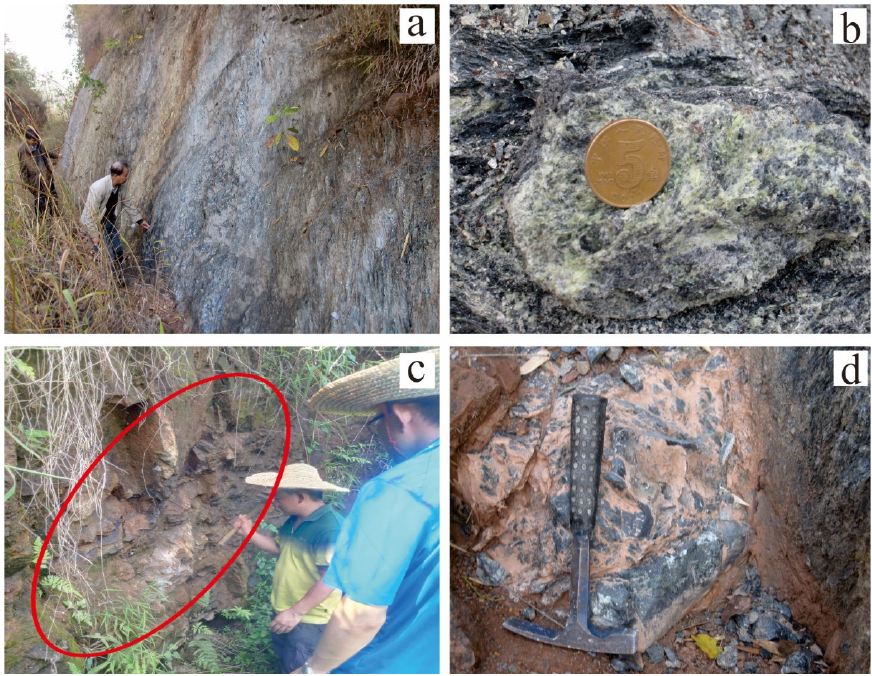
Figure 3. Santaishan ultramafic outcrops and hand specimens ( a , b ), Yingjiang ultramafic outcrops and hand specimens ( c , d ).